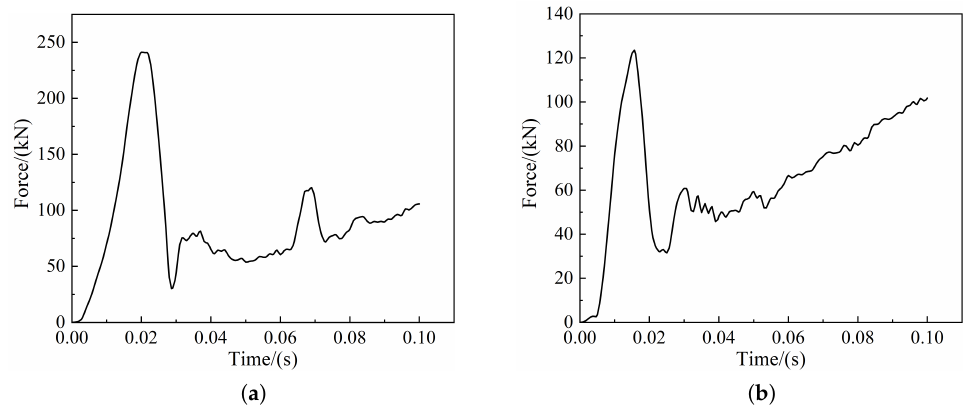
Figure 27. Coupler force curve: ( a ) Cow head-on collision; ( b ) Cow offset collision.